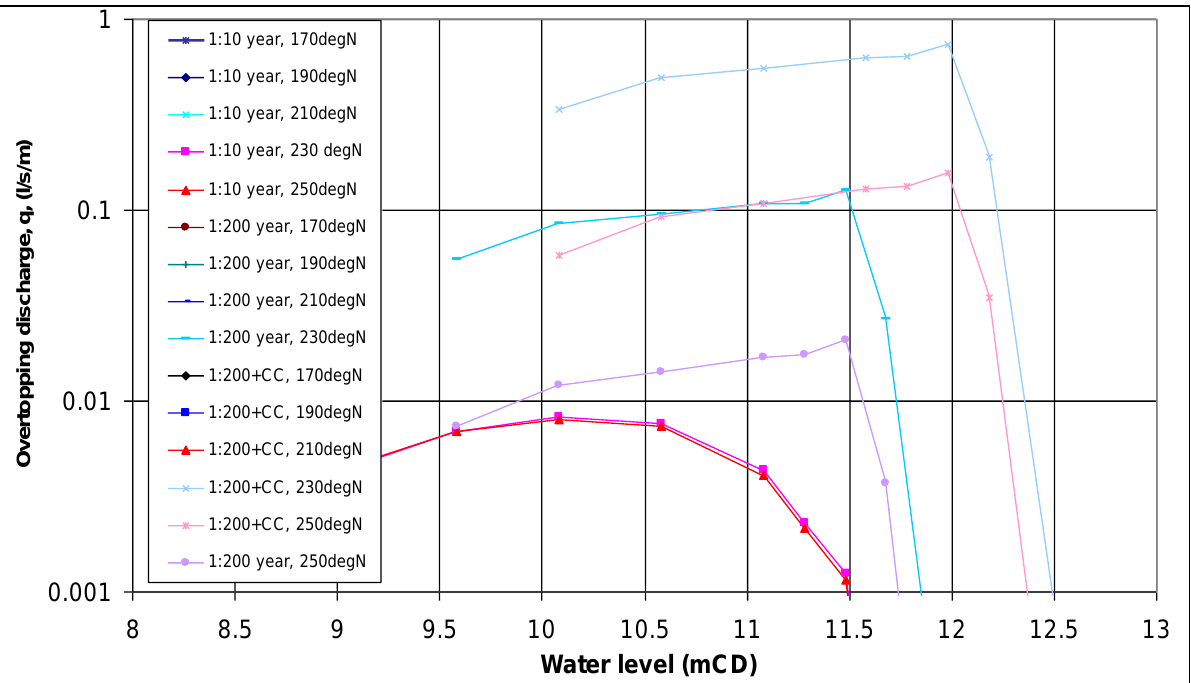
14 of 17 Figure 12. Refined JPA conditions for Position C3. 4.4. Wave Overtopping It can be appreciated that it was not possible to predict beforehand which combina- tion of water level, wave height and direction would maximise overtopping. Overtopping discharges were therefore calculated for each combination of wave direction, JPA water levels and wave conditions at 1:10, 1:200 and 1:200 year + climate change. These calculations were then repeated using different refurbishment options and land-use scenarios: Phase 1a — a near future conditions where land use continues as present, tested against 1:10 year combinations of water level and waves; Phase 1b — a future condition where there would be no sensitive use close to the de-